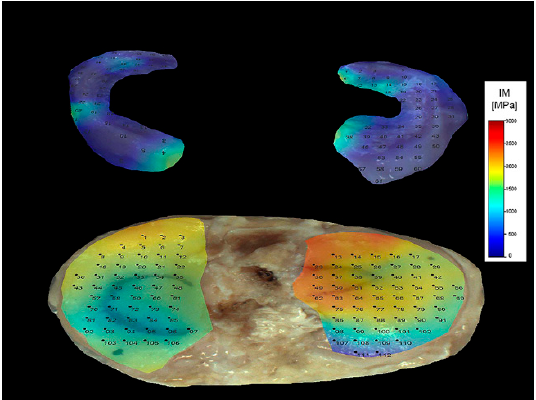
Figure 6. Combined mapping of IM of joint cartilage and associated menisci.